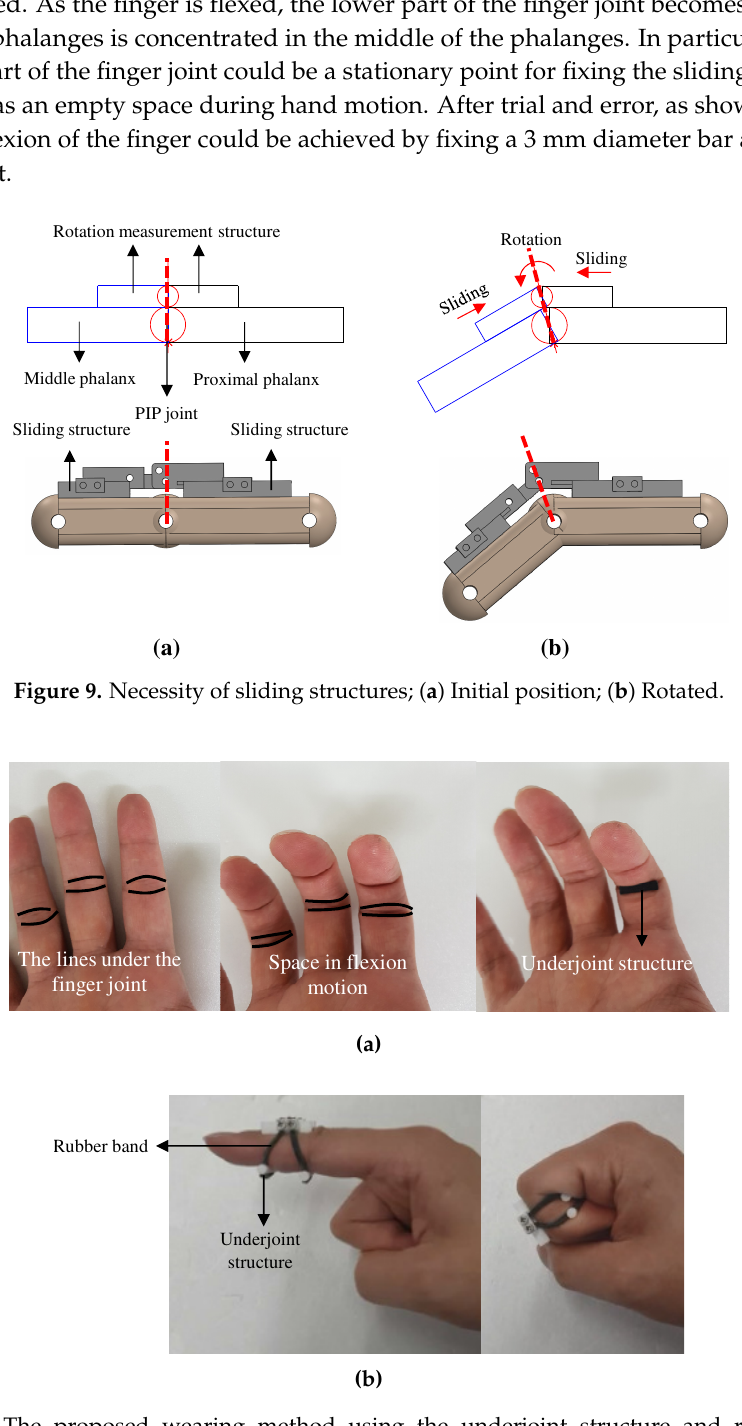
Figure 10. The proposed wearing method using the underjoint structure and rubber band; ( a ) Observation of the space under the finger joint; ( b ) The effectiveness of the underjoint structure in full flexion